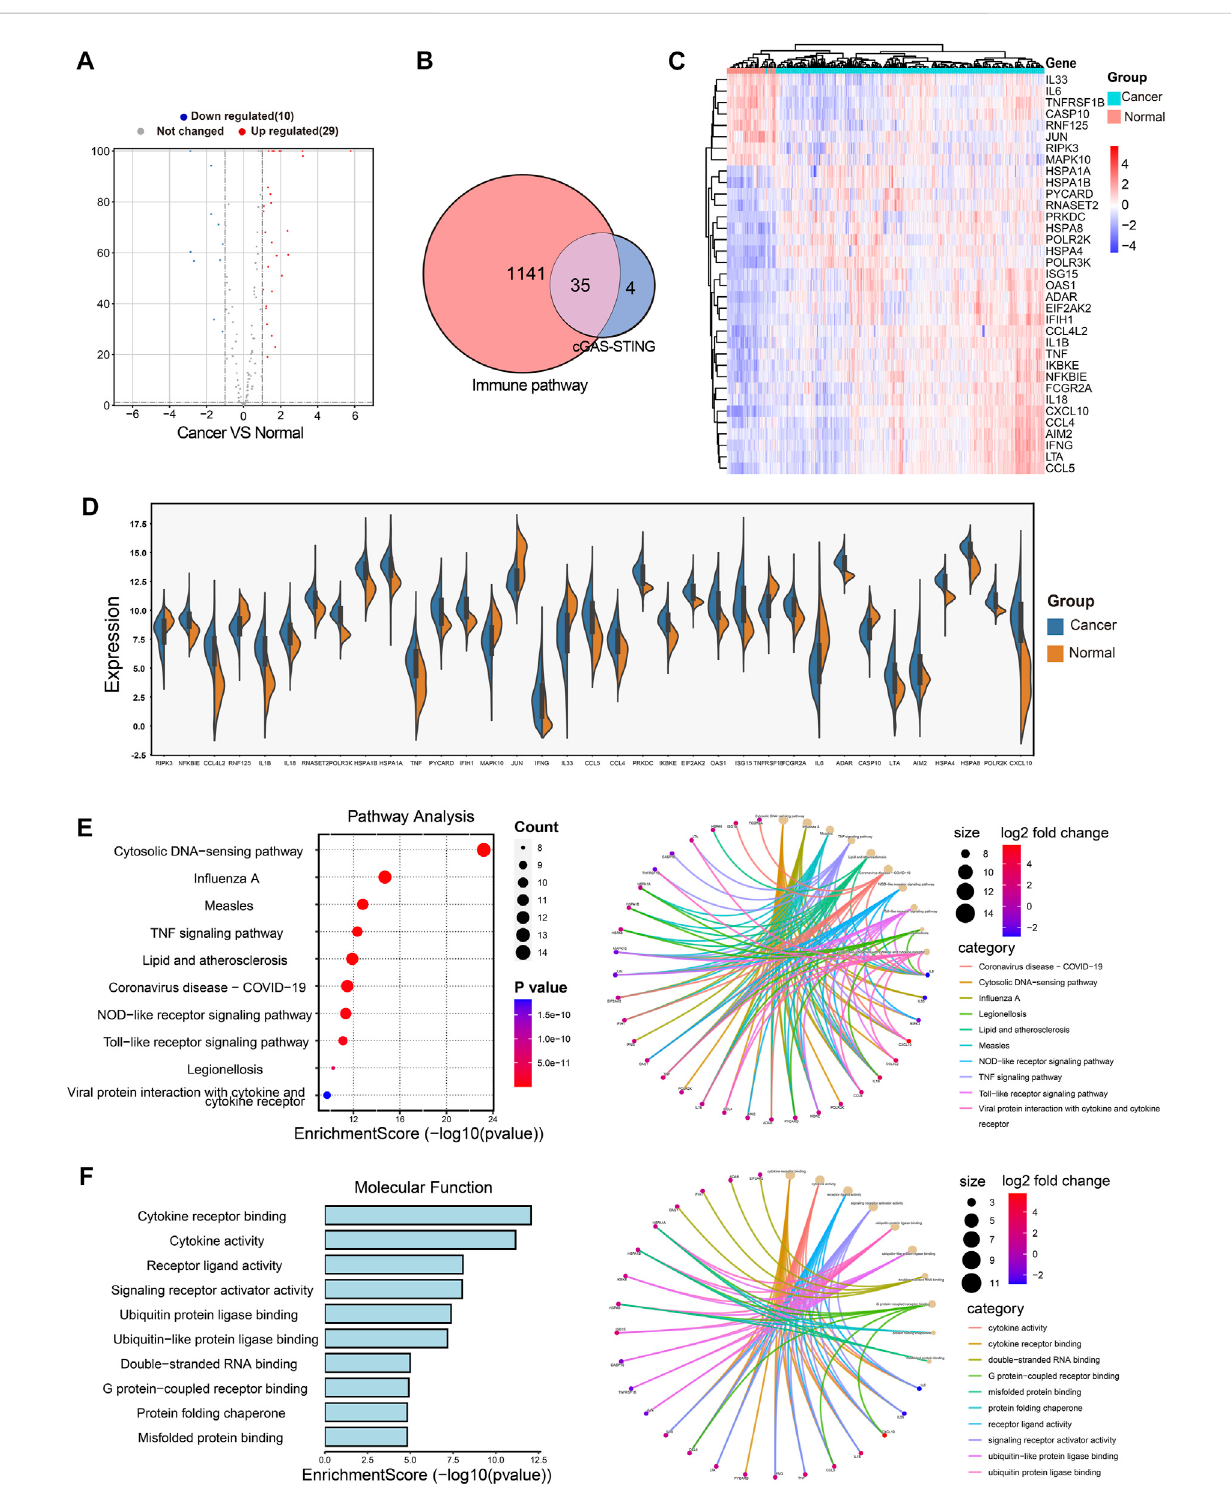
FIGURE 2 Identi fi cation of the immune-related DEGs of CSRGs in normal breast tissues and breast cancer tissues. (A) Volcano plot illustrated 39 DEGs of CSRGs compared normal breast tissues with breast tumor tissues. (B) Venn plot found the 35 DEGs of CSRGs were contained in 1141 DEGs of immune pathway-related genes. (C) Heat map showed the expression distribution in two groups. (D) The expression of 35 DEGs was displayed in a split violin diagram. (E) KEGG enrichment analyses showed the top 10 enriched pathway characteristics of 35 DEGs. (F) GO analyses described the top 10 molecular functions of 35